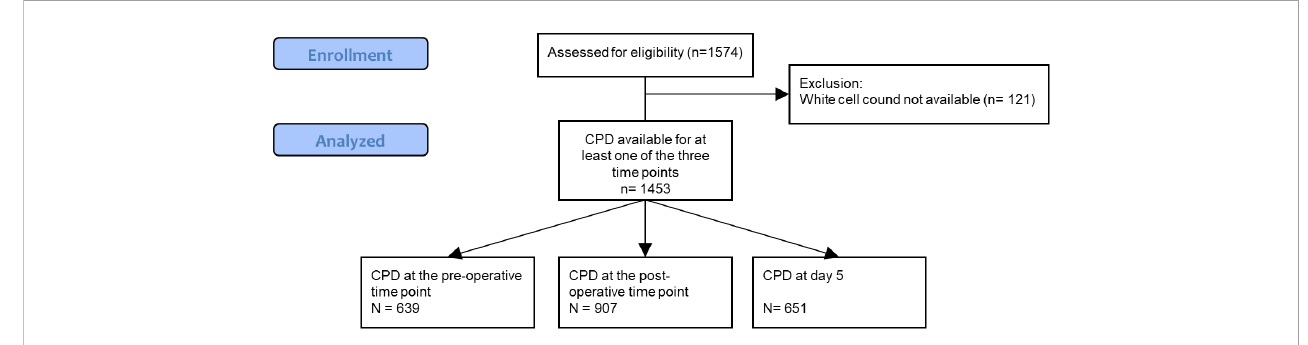
FIGURE 2 Study fl ow chart. CPD, Cell Population Data.